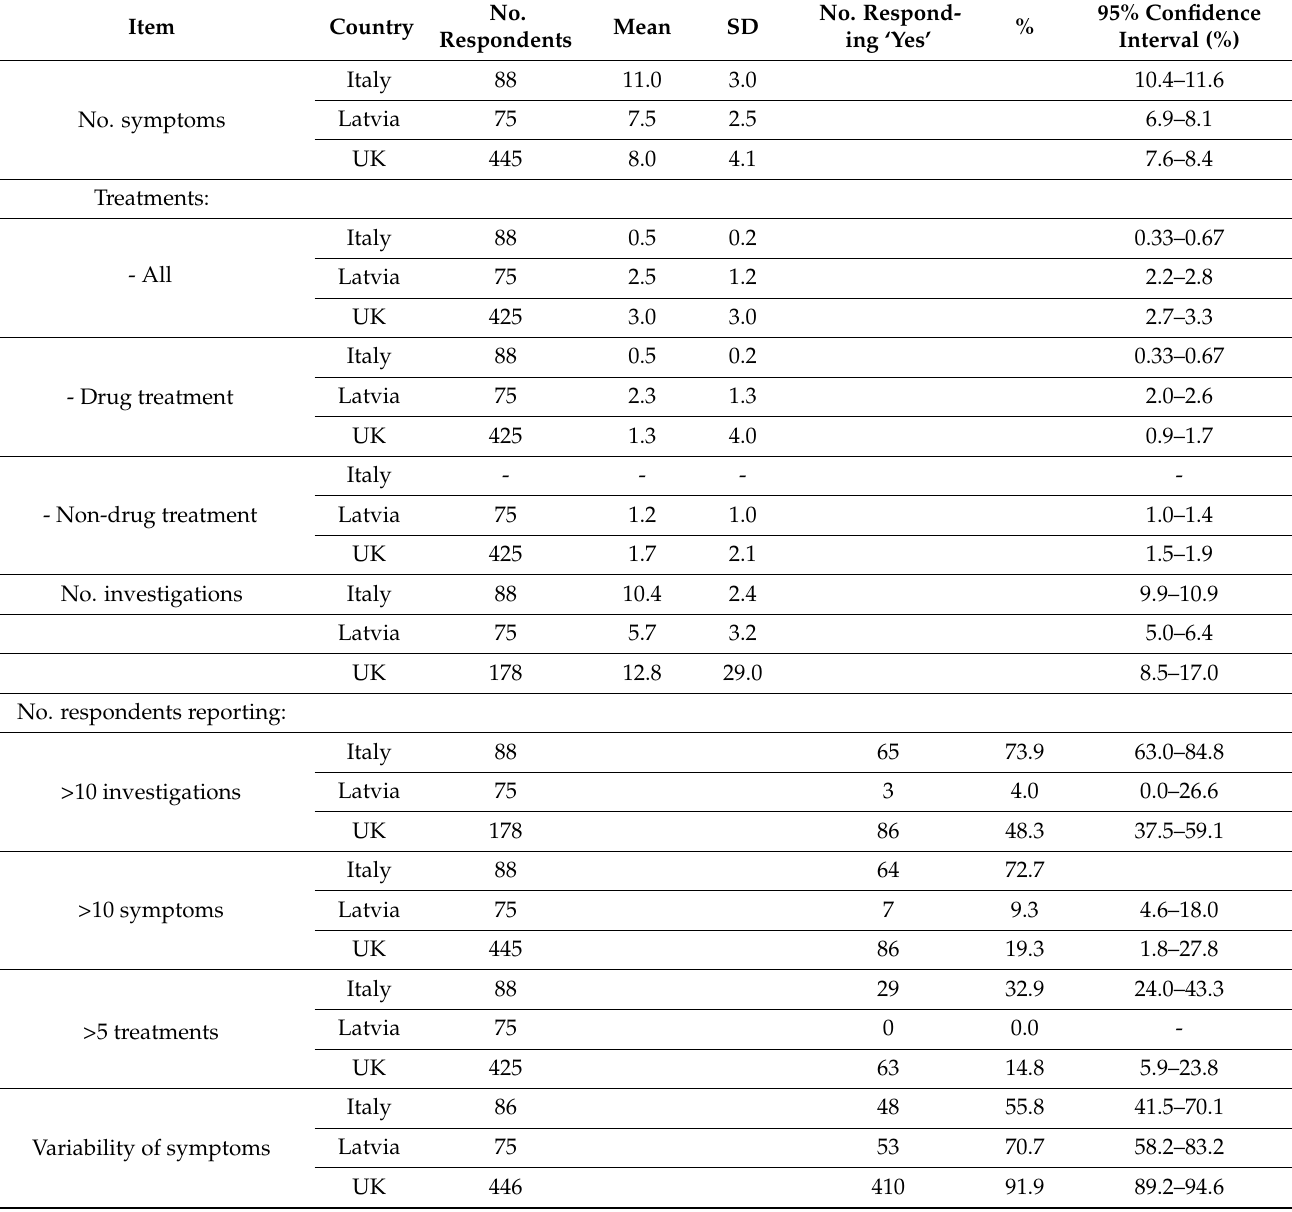
Table 3. Disease progression and